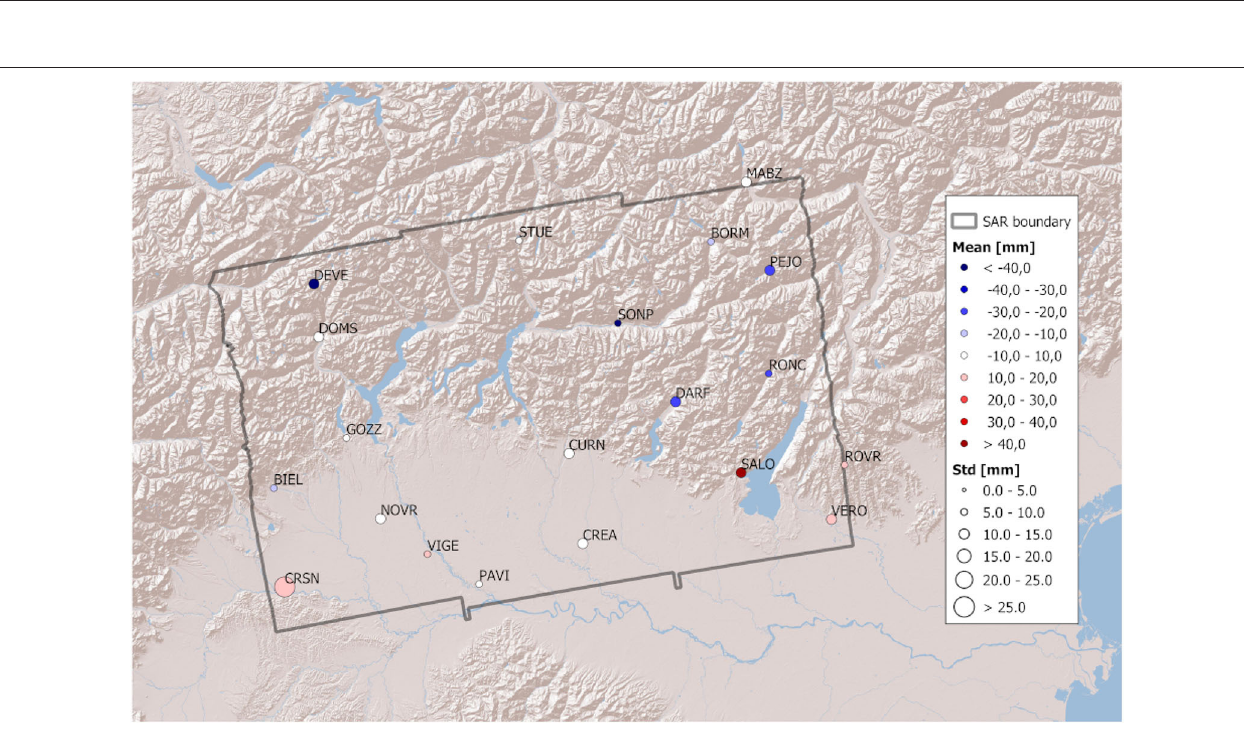
Frontiers in Earth Science |